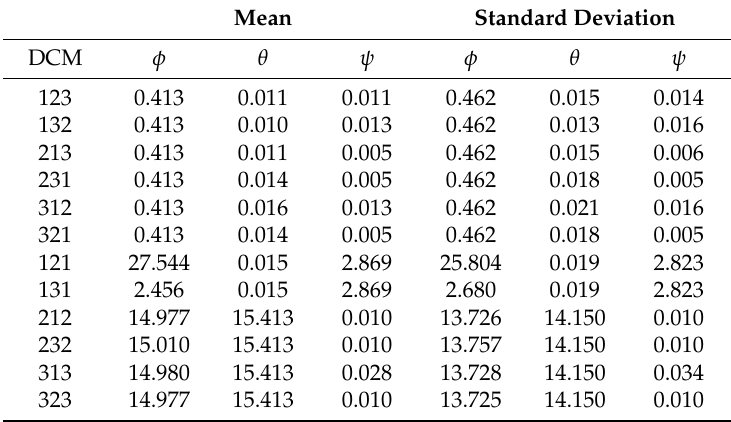
Figure 4. Euler and Body Angle deviation, using a 0.1 step size. Table 1. Mean and standard deviation for all 12 rotations, using a 0.1 step